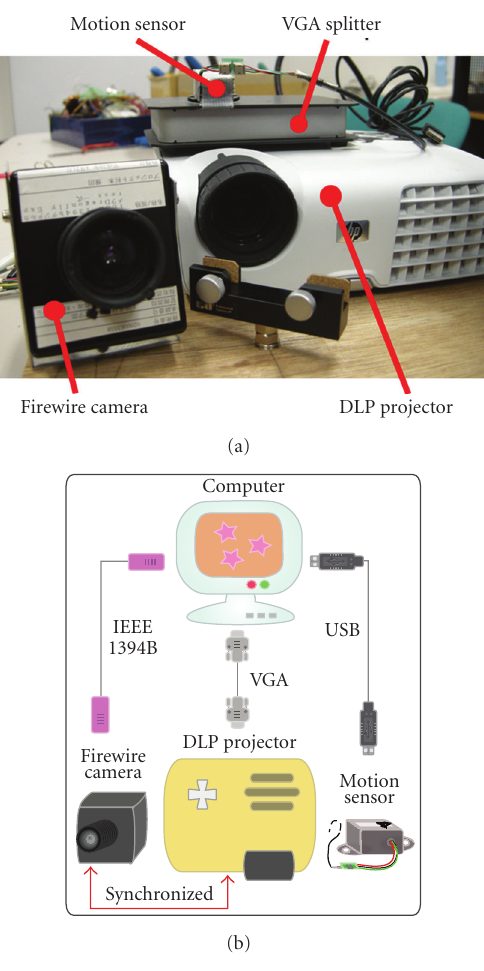
Figure 6: Projector-camera-sensor